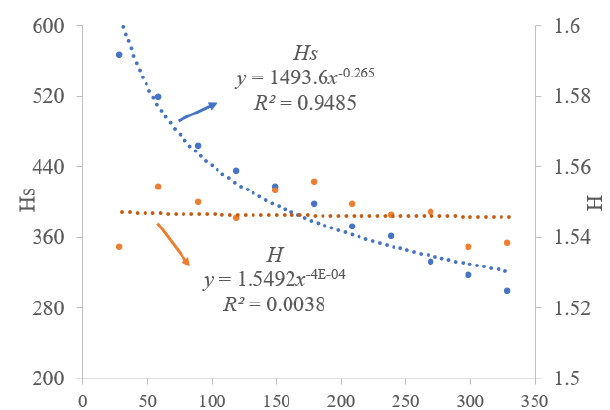
Figure 3. The results of Shannon diversity index and Spatial Entropy index.